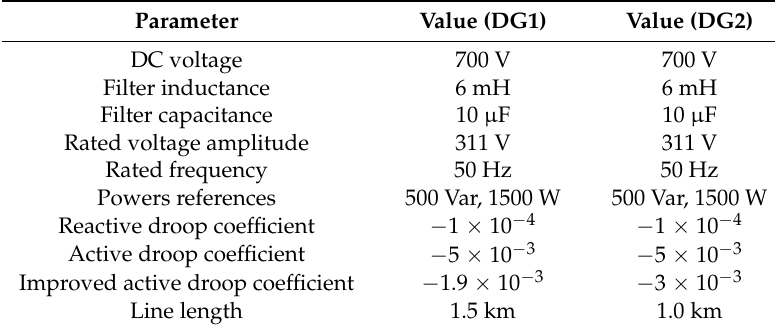
Figure 8. Single-phase equivalent circuit diagram of tested low-voltage microgrid model. Table 1. Parameters of tested low-voltage microgrid model.